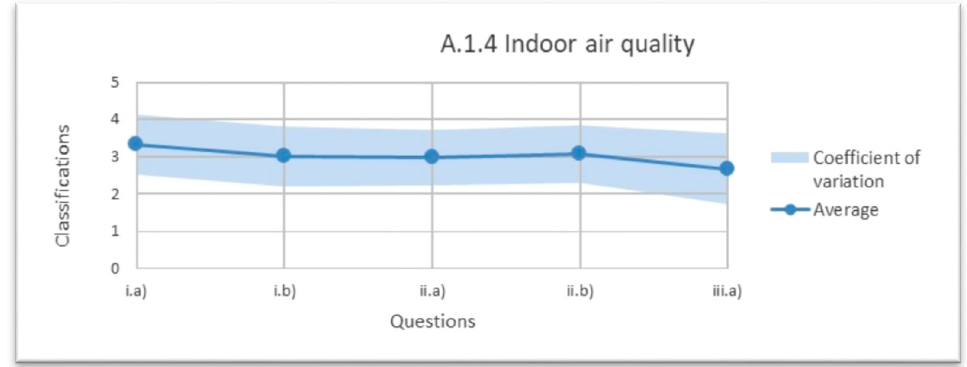
Figure 6. Average ratings of indoor air quality.